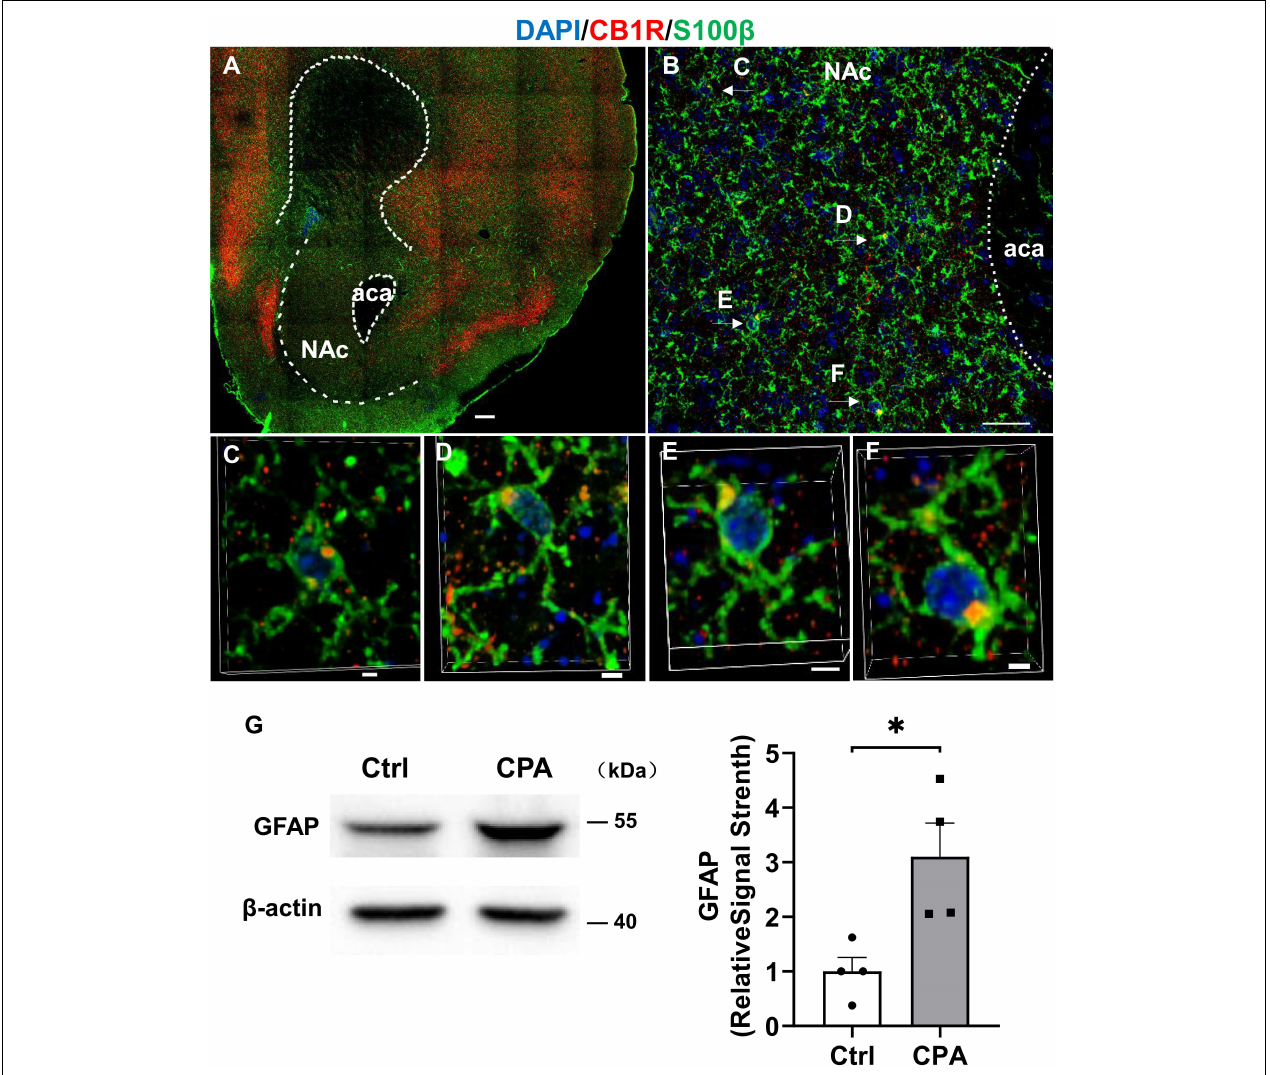
FIGURE 5 | Astroglia in the nucleus accumbens express CB1R and they are activated after conditioned place aversion induction by CP 55,940. (A) Representative montage of the nucleus accumbens in Cnr1 + / + mouse stained for S100 β (astroglial marker) and CB1R. Scale bar 250 µ m. (B) Co-localizations of S100 β and CB1R indicated by the arrows. Scale bar 25 µ m. (C–F) 3D enlargement to illustrate the co-localizations of S100 β and CB1R indicated by the arrows in panel (B) . Scale bar 2.5 µ m. (G) Representative (left) and quantification of Western blotting (right) showing GFAP expression in the control mice and mice with conditioned place aversion induction. ∗ P < 0.05 (Student’s unpaired t